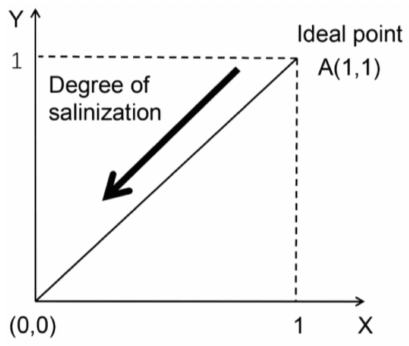
Figure 10. Simplified diagram of the feature space.